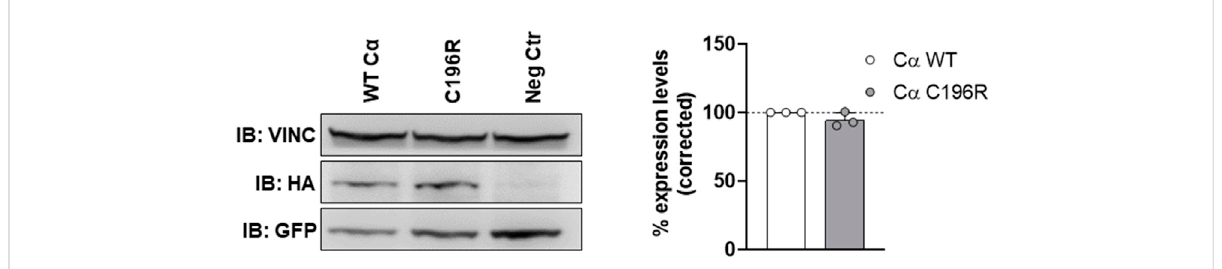
FIGURE 4 Assessment of variant expression in HEK293T cells. Equal amounts of HA-tagged WT and variant C α expression plasmids were co-transfected withanequalamountofGFP(green fl uorescentprotein)expressionplasmid.PresenceofHA-taggedC α ,GFPandvinculininthelysateswasassessed by anti-HA, anti-GFP, and anti-vinculin immunoblotting, respectively. Left panel: immunoblot from a representative experiment. As a negative control (Neg Ctr), pMB001 vector without insert was co-transfected with a GFP expression plasmid. Right panel: graph displaying expression levels of HA-tagged C α WT or C α p.Cys196Arg corrected to an internal (vinculin expression) and transfection ef fi ciency (GFP expression) control. Results represent the average value ±SD of the ratios of the corrected HA signal to the corrected GFP signal in relation to the values of WT C α (set